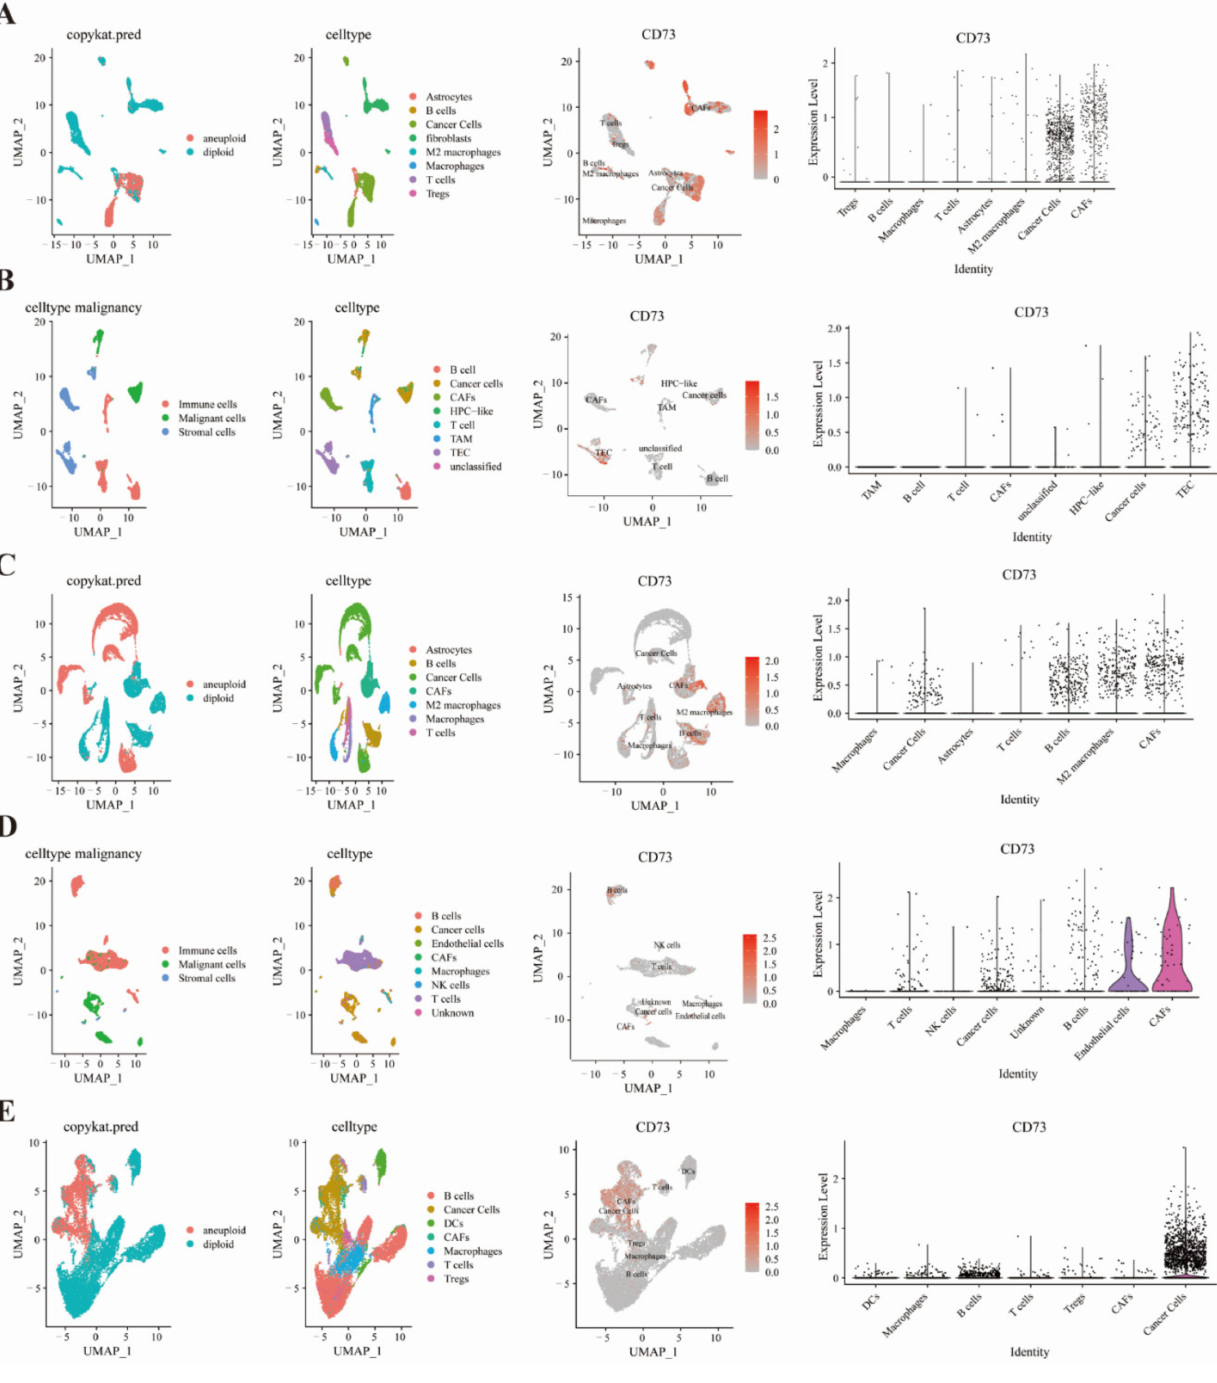
Figure 5. Single-cell analysis shows that CD73 is significantly expressed on tumors and some immune cells. CD73 expression on various cell types in TME based on the R package in HNSCC ( A ), LIHC ( B ), prostate cancer ( C ), SKCM ( D ), and STAD ( E